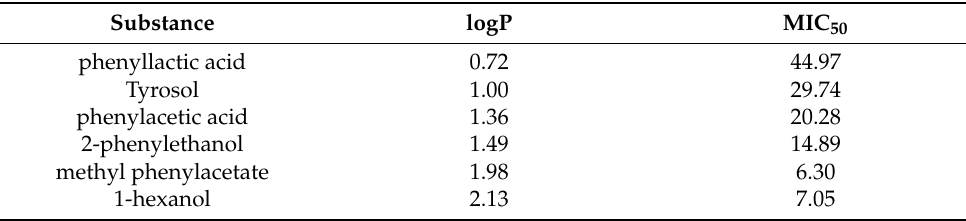
Table 1. LogP and MIC50 values of 2-PEtOH and